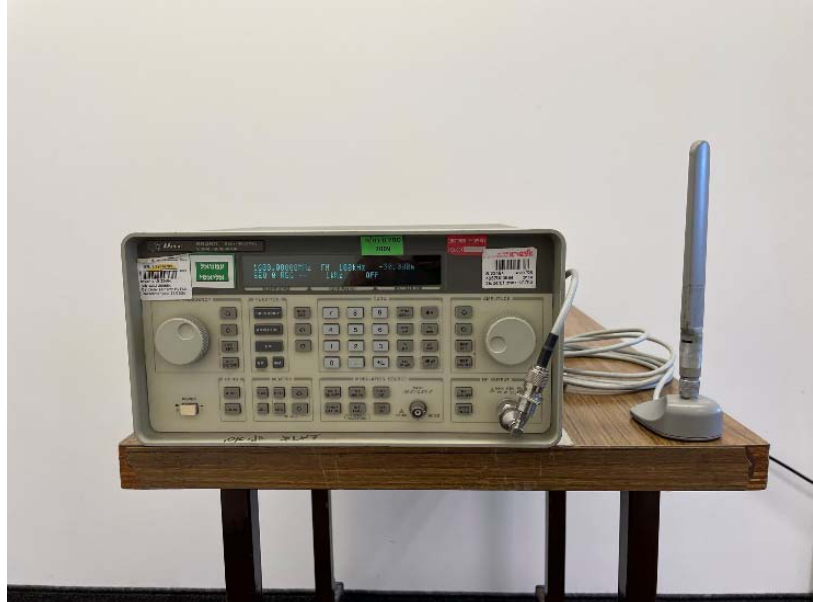
Figure 5. Signal generator and transmitting antenna.